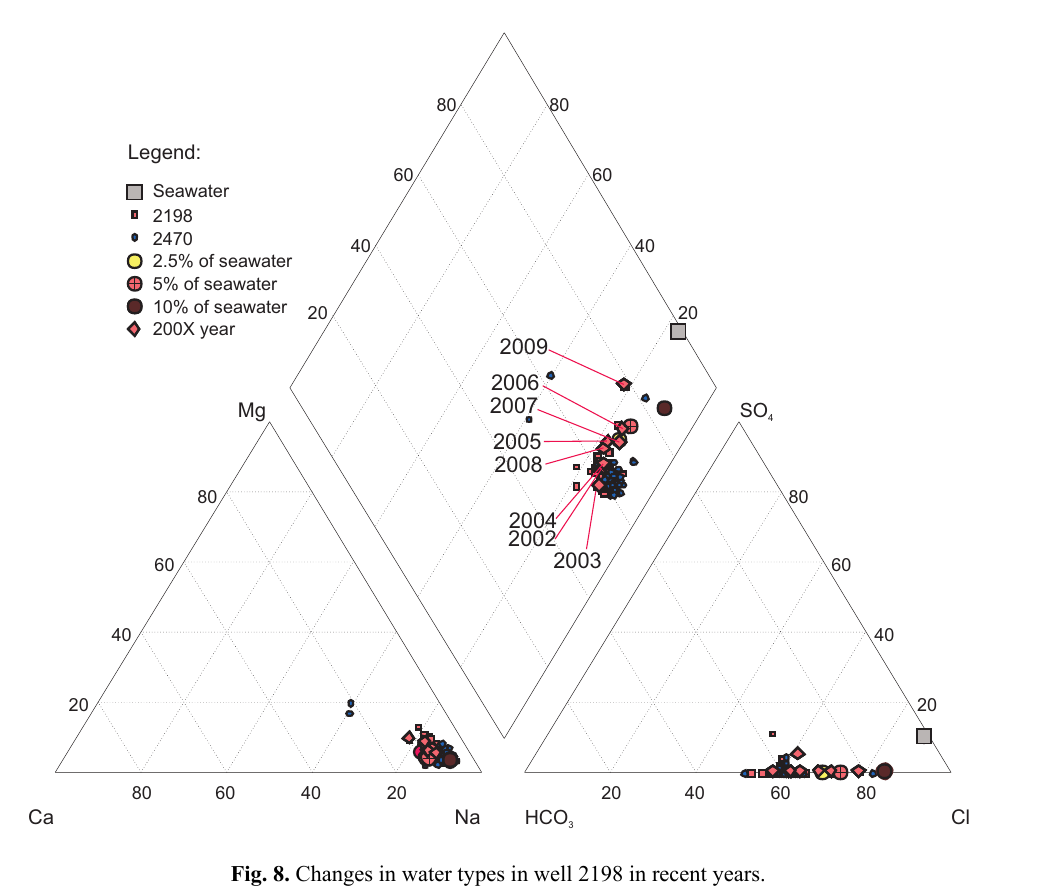
HCO 3 (cid:150) /Cl